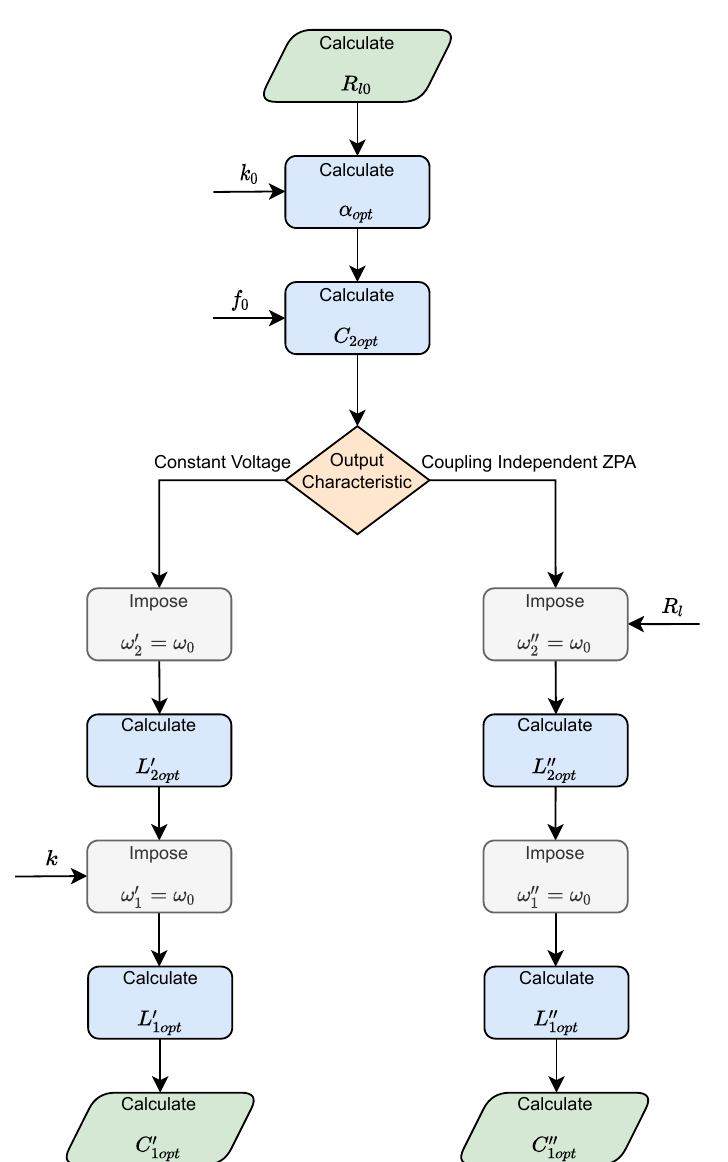
Figure 2. Flow chart illustrating the design algorithm for the inductive coupling and the compensa- tion networks based on the selected output characteristic. The load resistance R l and the coupling coefficient k refer to actual parameters during variable operating